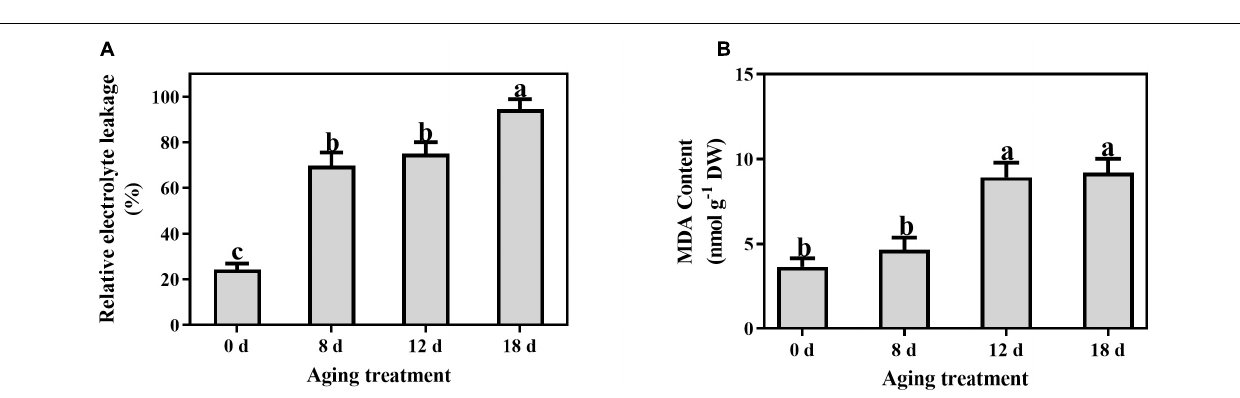
FIGURE 4 | Effects of artificial aging treatment on (A) relative electrolyte leakage and (B) MDA content. Data shows the mean ± SD of three biologically independent experiments. Columns marked with different letters (a-c) are statistically significantly different ( p < 0.05).